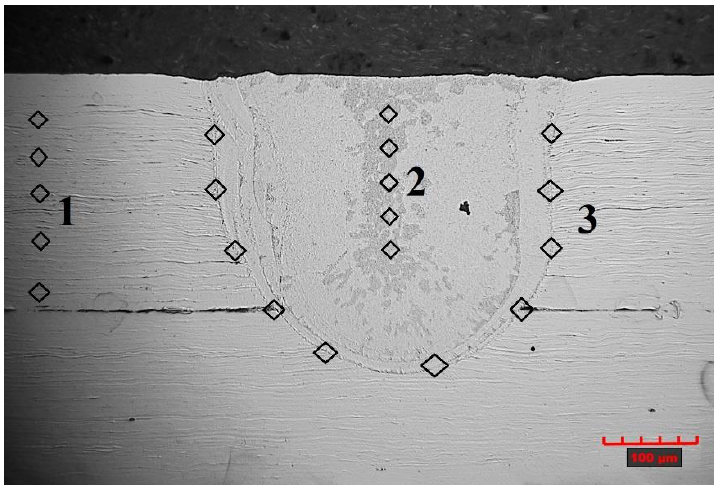
Figure 10. The scheme of microhardness measurements: the tube core material (1); the central part of the penetration (2); near the fusion penetration line (3).